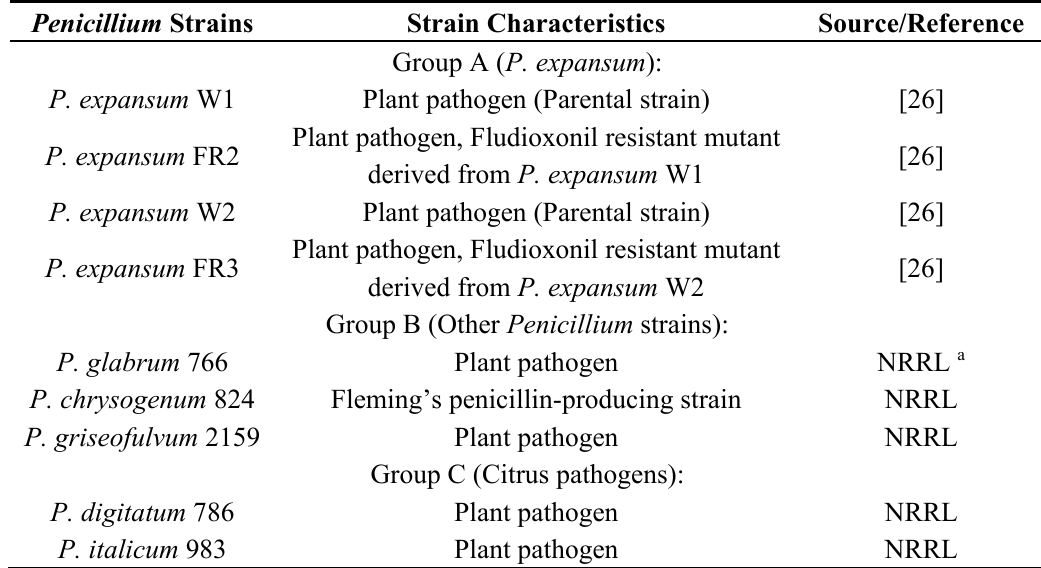
Table 1. Penicillium strains used in this